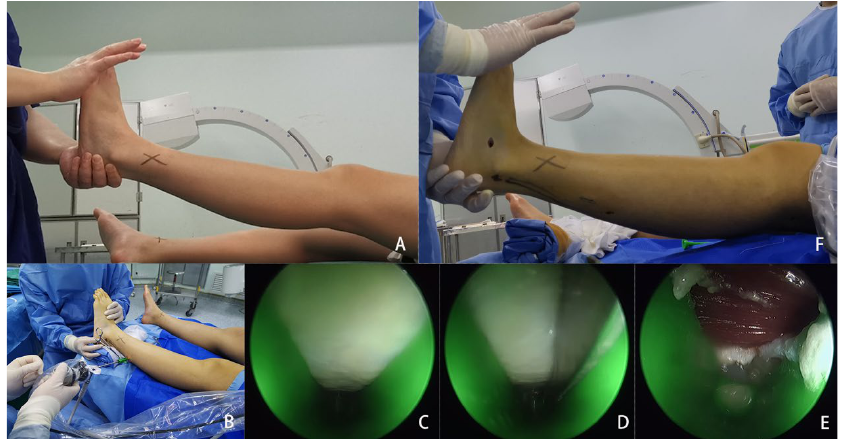
Figure 2. Surgical images of the endoscopic gastrocnemius recession using the Modified Soft Tissue Release Kit. ( A ) Preoperative examination showed obvious limitation of ankle dorsiflexion; ( B ) A 2.7 mm, 30 ° endoscope was used for observation; ( C ) The entire gastrocnemius aponeurosis was observed in the endoscopic view; ( D ) The gastrocnemius aponeurosis was incised with the hook knife; ( E ) The muscular tissue can be observed after the complete release of the gastrocnemius aponeurosis; ( F ) The ankle dorsiflexion angle improved significantly